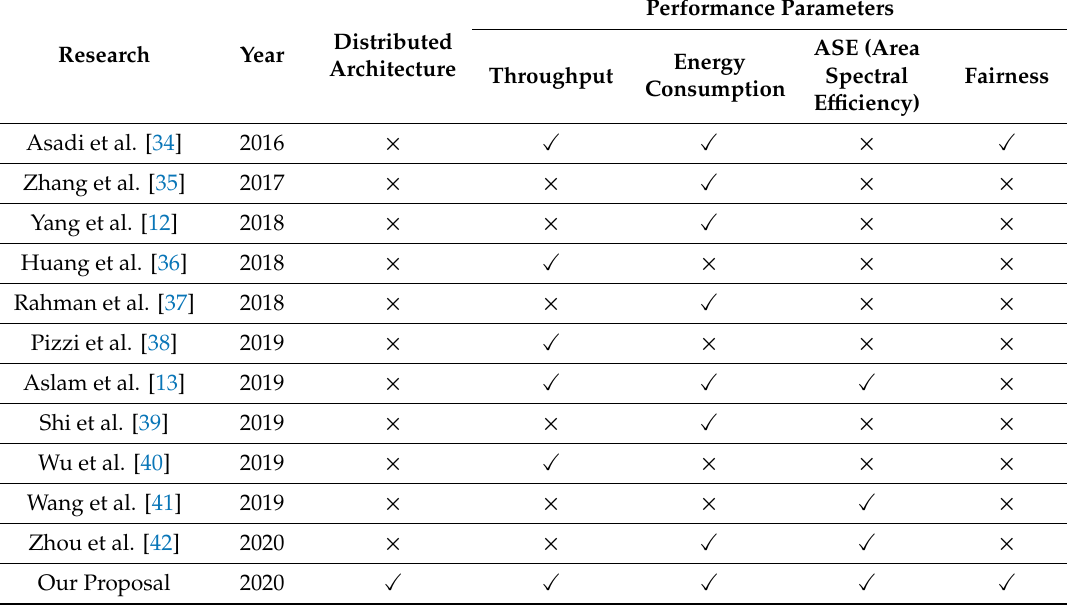
Table 1. Summary of related research articles.